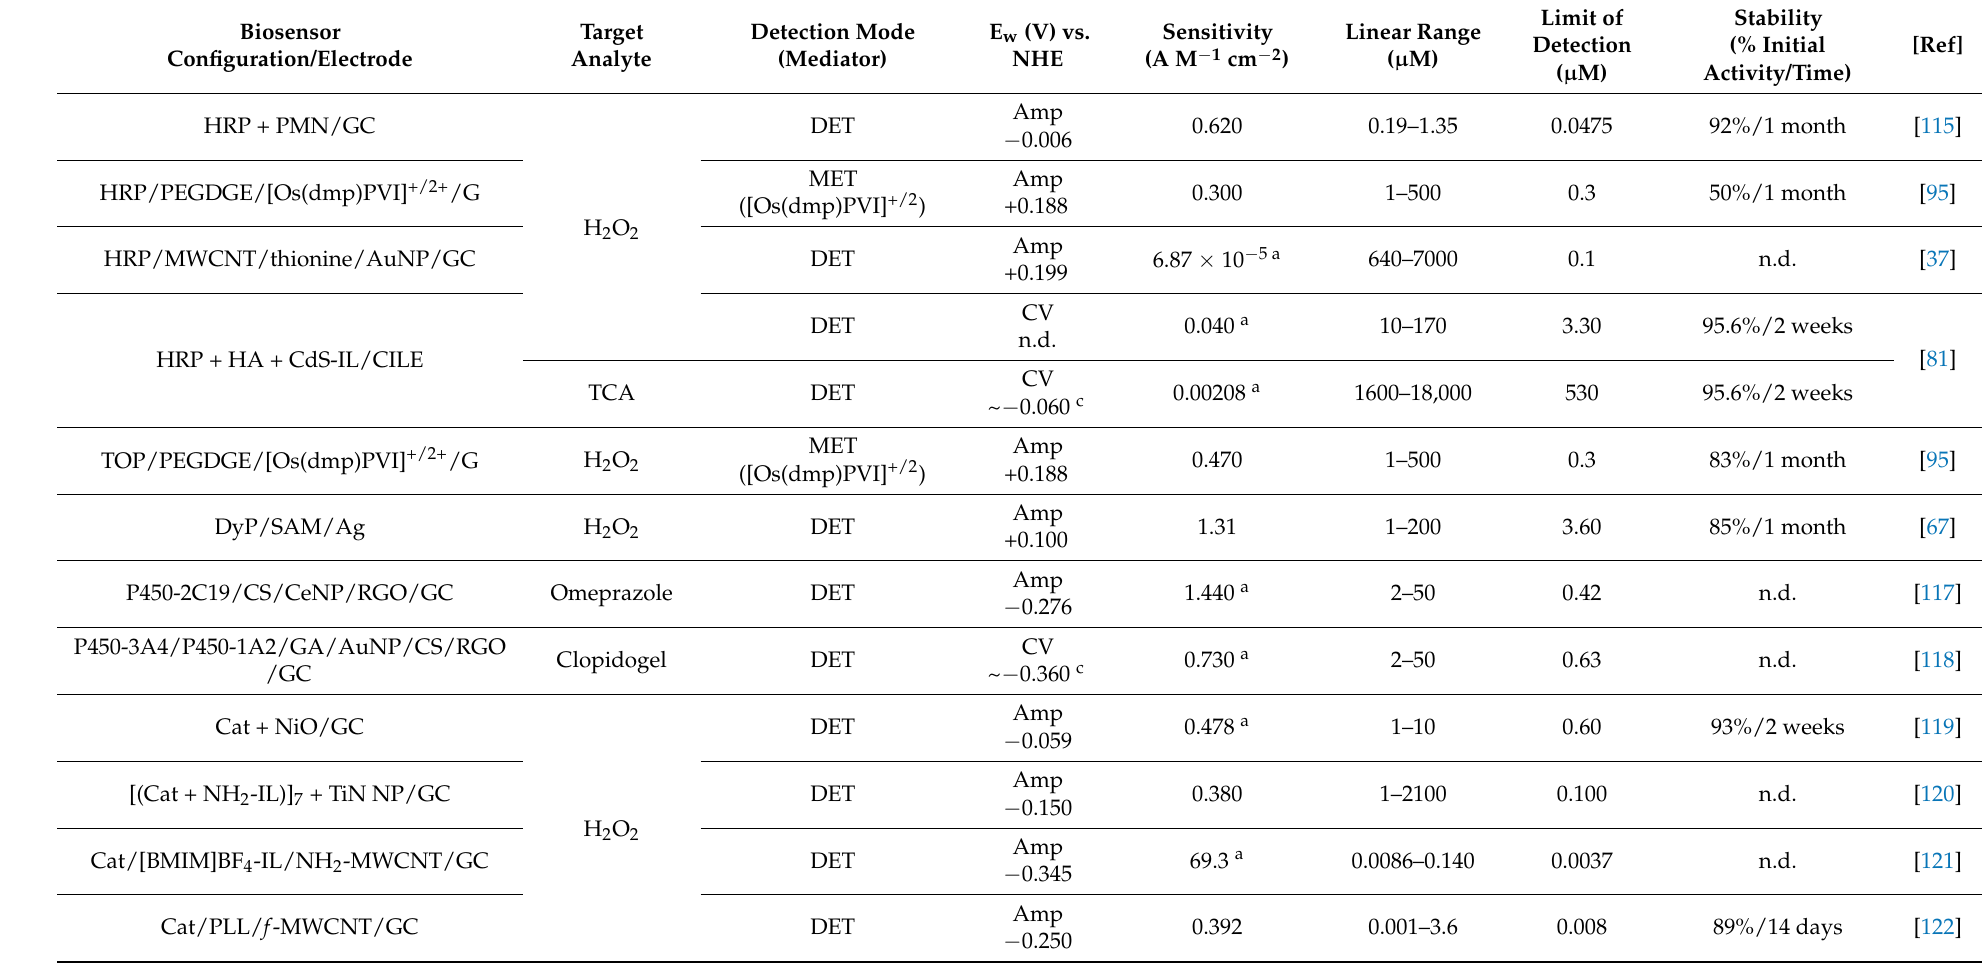
Table 1. Analytical parameters of heme protein-based biosensors. E W —Working potential; a/b —normalized using the electrode geometric/active area; c —estimated from electrochemical data shown in the reference; n.d.—not